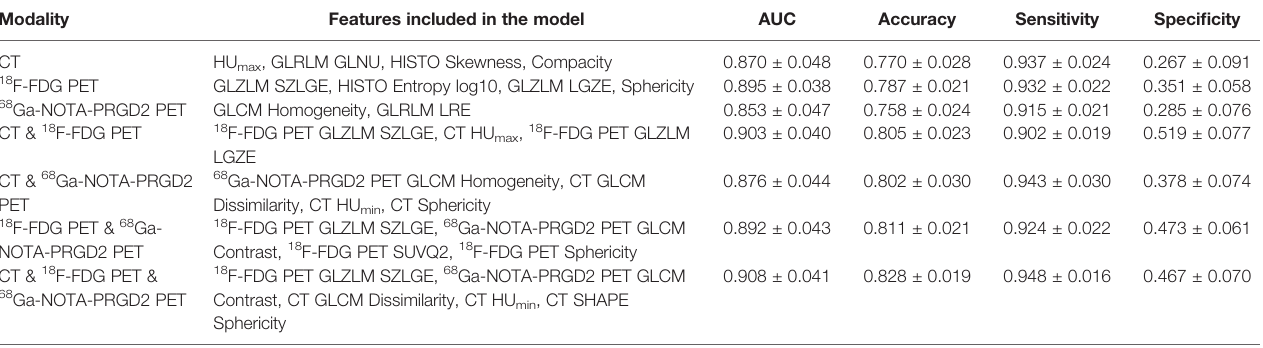
TABLE 3 | Feature composition and evaluation results of models for the differentiation of benign and malignant lesions.